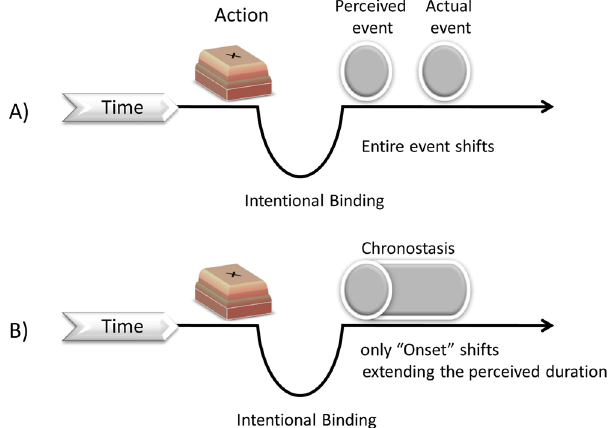
Figure 1. Pictorial representation depicting ( A ) Intentional binding where the “entire event shifts” towards the action, and ( B ) where only the “onset shifts” towards the action leading to temporal expansion of the outcome. Temporal expansion associated with actions is also referred as chronostasis 18, 19 .